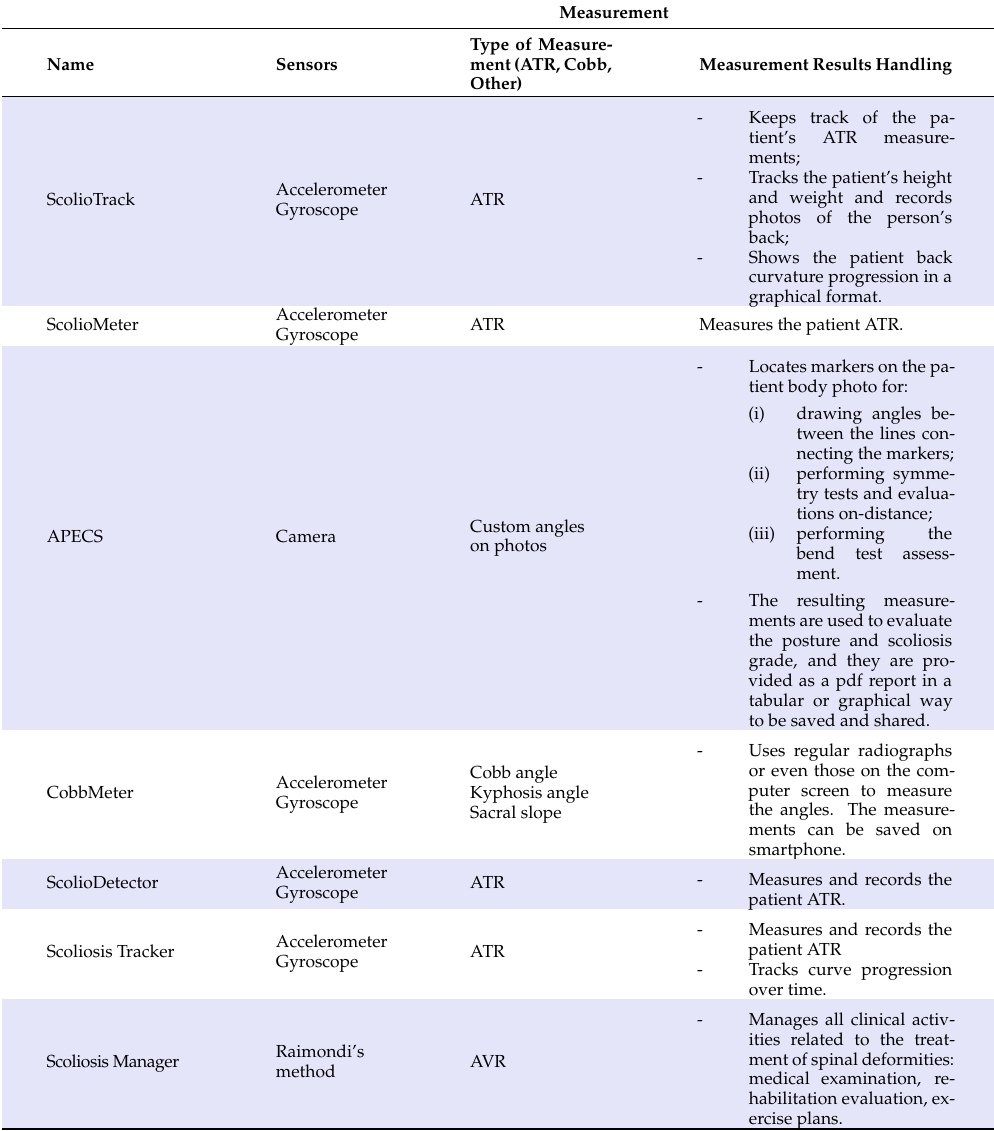
Table 2. Comparison of the tools with respect to the measurement macro-category. Note that only APECS uses the camera to acquire measurements. APECS draws custom angles on the patient photo to perform the Adam’s forward bend test assessment